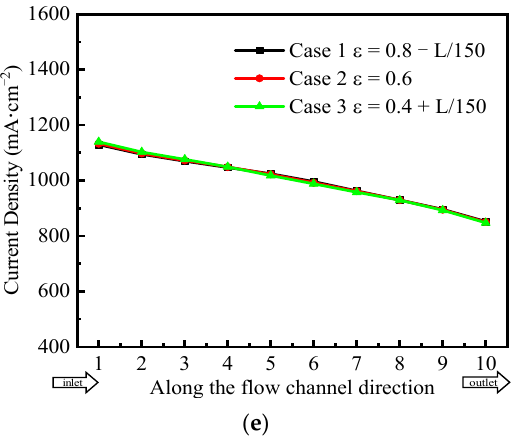
Figure 10. Comparison of the physical parameter distribution for the three different cases. ( a ) Gas velocity, ( b ) oxygen concentration, ( c ) liquid saturation, ( d ) water content, and ( e ) current density.